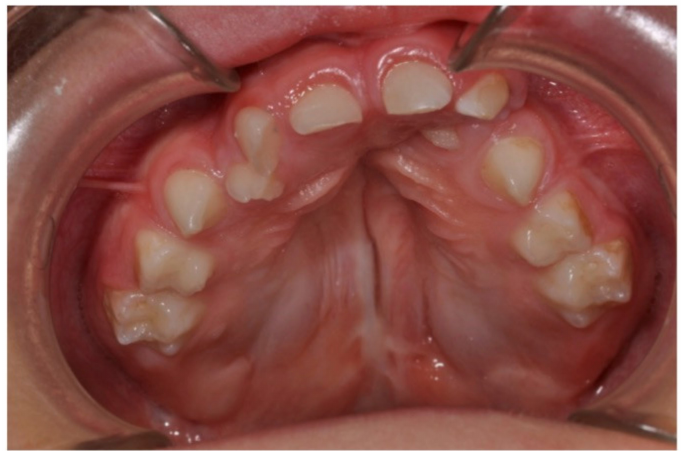
Figure 4. Delayed exfoliation of the deciduous elements and eruption delays.